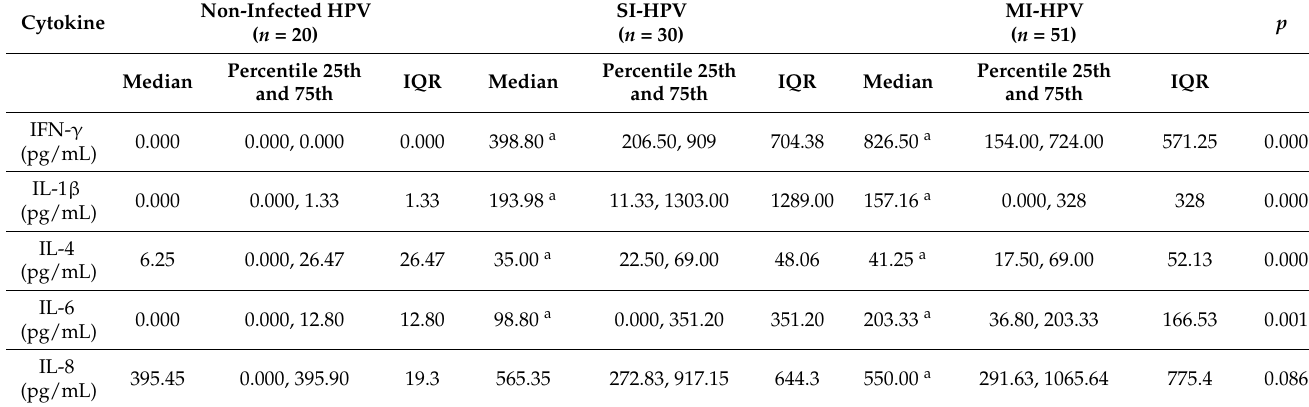
Table 5. Cytokines and oxidative stress biomarkers in semen